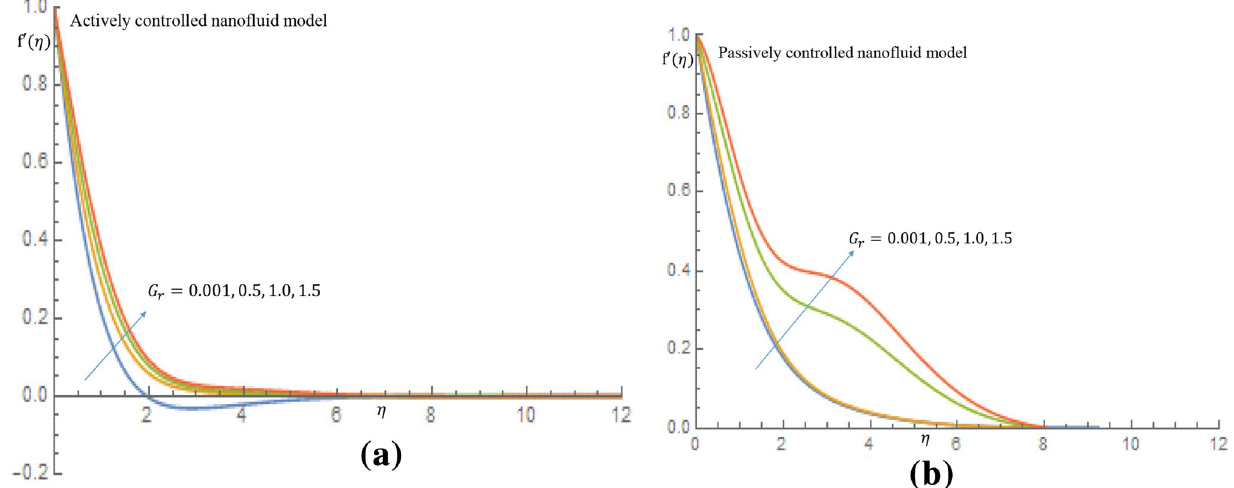
Figure 4. ( a ) Effect of G r on velocity profile when N r = N b = 0.75 . ( b ) Effect of G r on velocity profile when N r = N b = 0.75 .